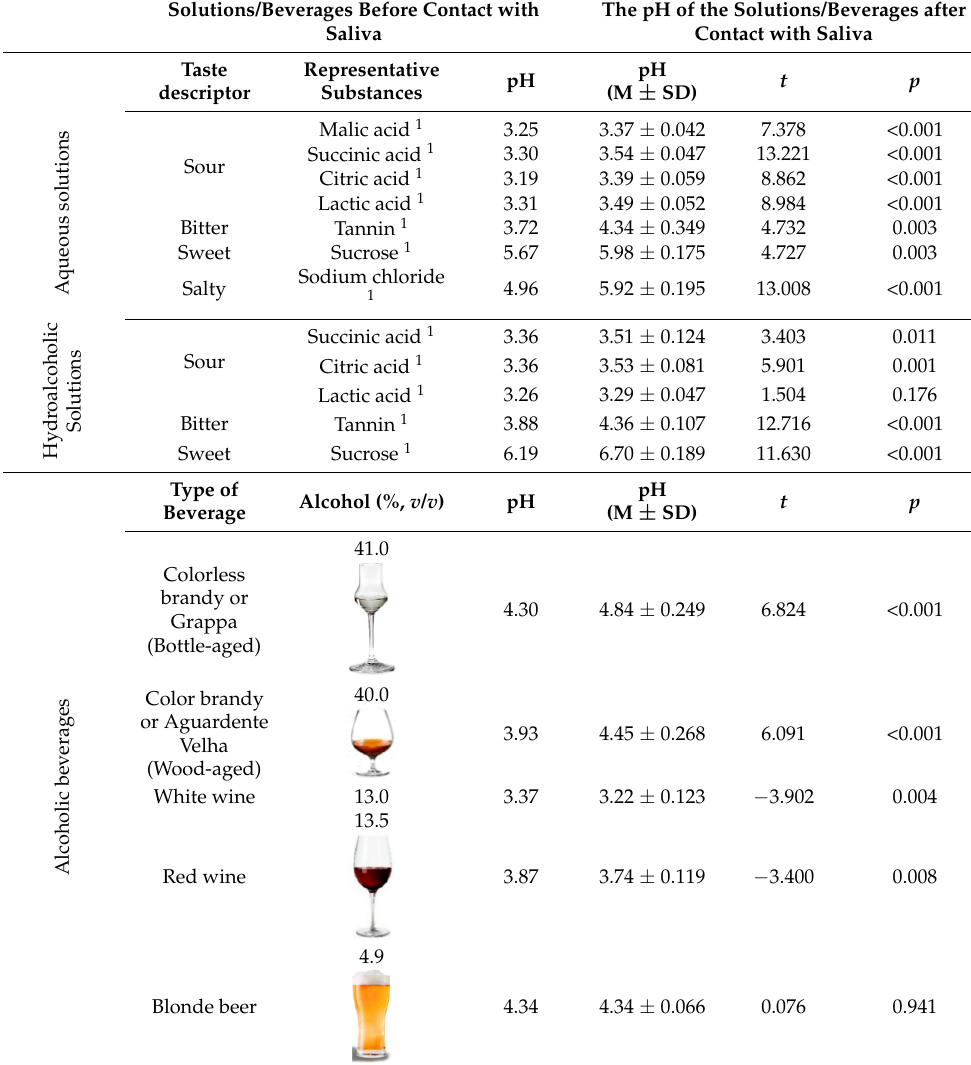
Table 2. pH of aqueous solutions, hydroalcoholic solutions, and alcoholic beverages before contact with tasters’ saliva. Descriptive measures (M ± SD) and univariate effects of aqueous, hydroalcoholic, and alcoholic beverages after contact with saliva. In the case of alcoholic beverages, the alcohol content (%, v / v ) corresponding to each one is shown.